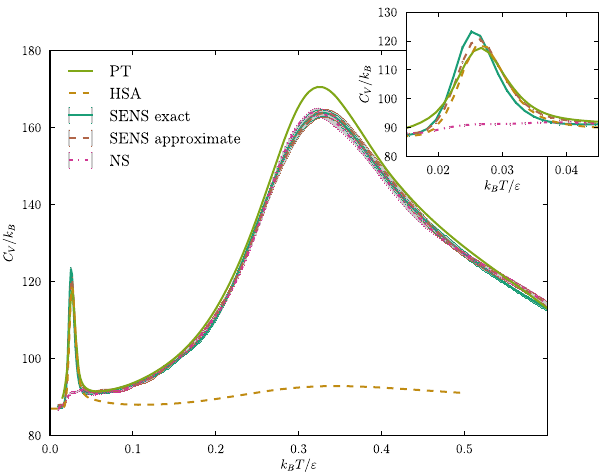
FIG. 1. Heat capacity curves for LJ 31 . PT and HSA correspond to parallel tempering and the harmonic superposition approxi- mation, respectively. All SENS calculations were performed using K ¼ 20 000 replicas.